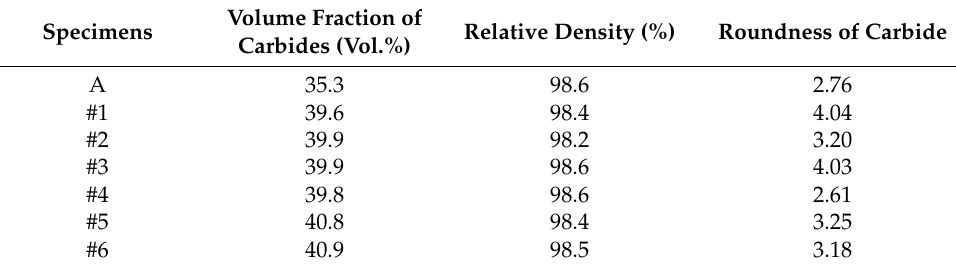
Table 4. The statistical results of OM images.